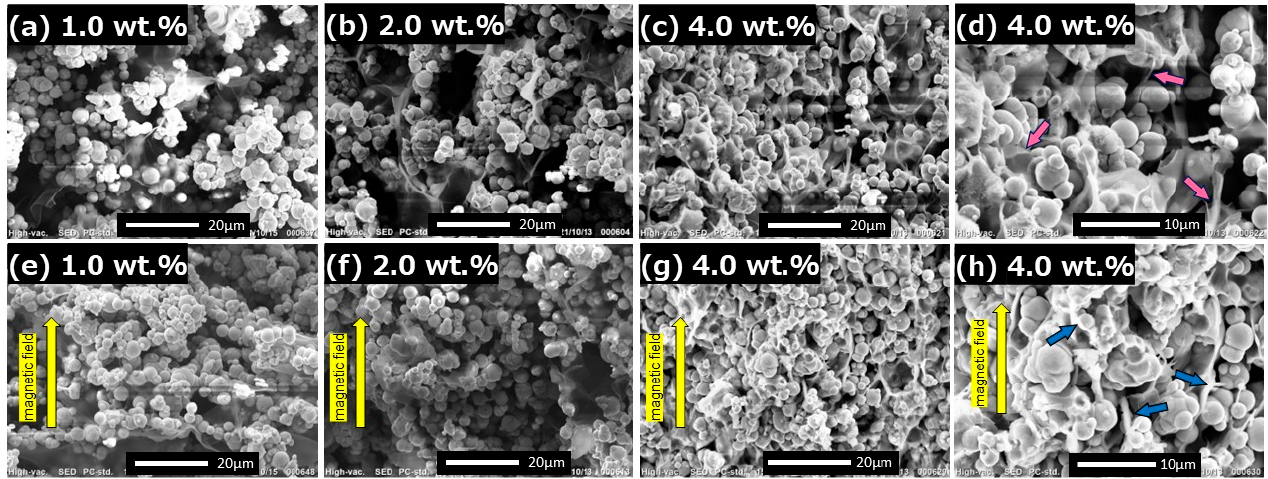
Figure 6. The SEM photographs for magnetic gels with various carrageenan concentrations at 0 mT ( top ) and 50 mT ( bottom ). Magnetic particle concentration: 50 wt.%.